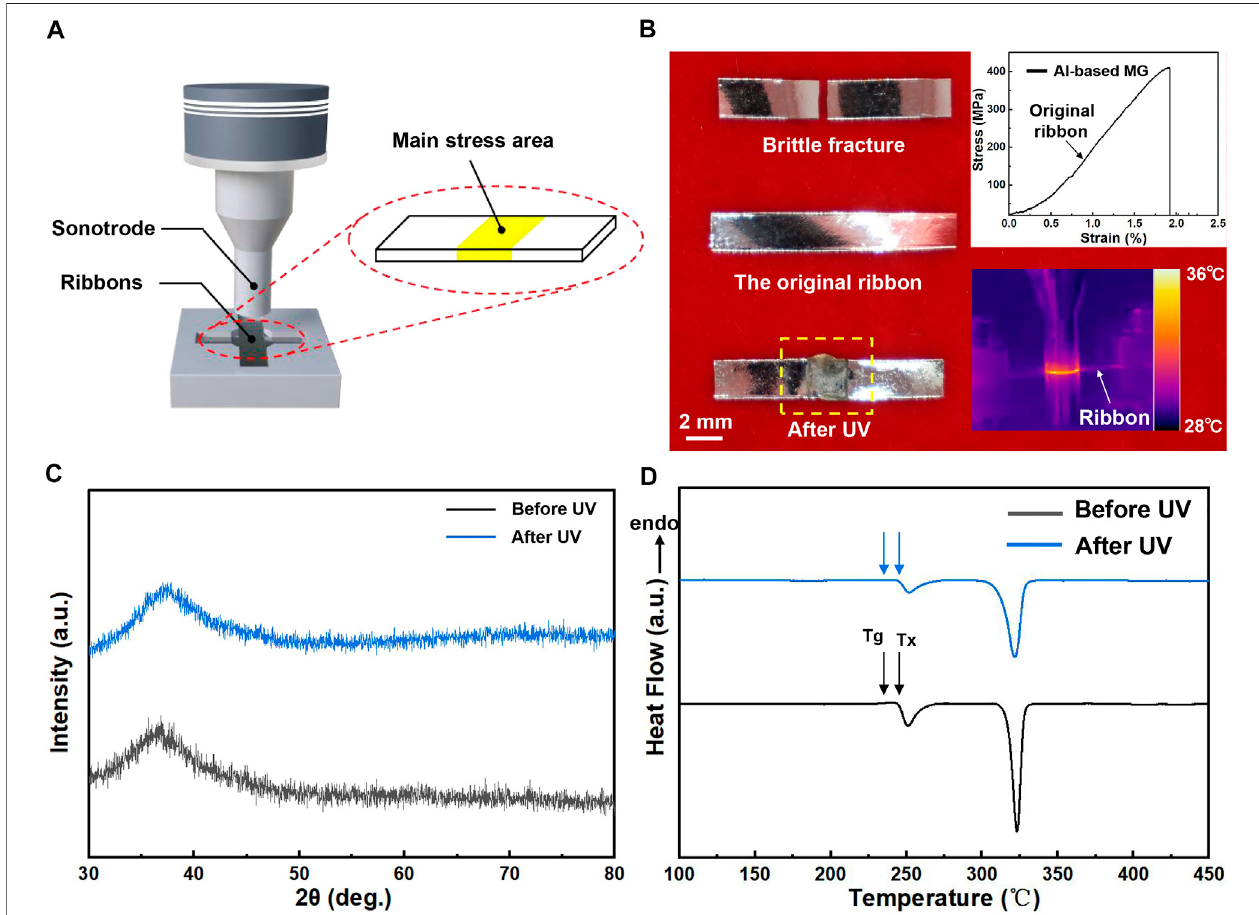
FIGURE 1 | The forming ability of Al-based MG. (A) Schematic diagram of the experimental set-up. (B) Comparison of Al-based amorphous alloy ribbon samples before and after UV. Tensile ribbon exhibiting brittle fracture and the corresponding tensile stress-strain diagram. (C) and (D) XRD pattern and DSC curve of the amorphous alloy ribbon before and after UV, respectively.